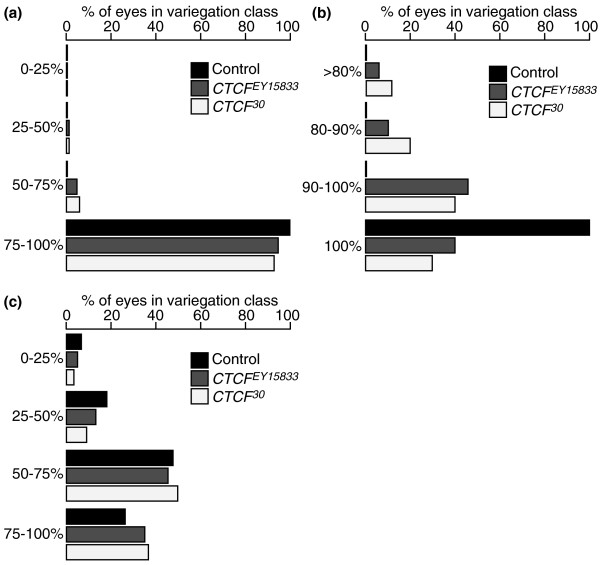
Eye phenotype of Dp(1;f)LJ9 Drosophila with dCTCF alleles. (a) Phenotypes of maternally inherited Dp(1;f)LJ9 mini-X chromosome ranging from 0% to 100% pigmentation; control n = 300, CTCFEY15833 n = 300, CTCF30 n = 300. (b) Phenotypes of maternally inherited Dp(1;f)LJ9 mini-X chromosome ranging from >80% to 100% pigmentation; control n = 150, CTCFEY15833 n = 132 (Kolmogorov-Smirnov test; P < 0.001) and CTCF30 n= 122 (Kolmogorov-Smirnov test; P < 0.001). (c) Phenotypes of paternally inherited Dp(1;f)LJ9 mini-X chromosome ranging from 0% to 100% pigmentation; control n = 300, CTCFEY15833 n = 300, CTCF30 n = 300. Each eye was scored depending on its phenotypic class, and the prevalence of each phenotypic class is expressed as a percentage versus the total number of eyes scored (n).